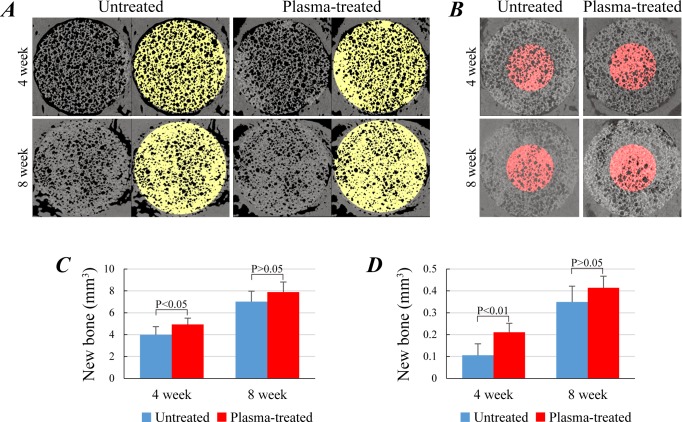
In vivo implantation of IP-CHA discs.(A) Images of μCT analysis of untreated and plasma-treated IP-CHA discs at 4 and 8-week time points after implantation. Yellow denotes the bony density (i.e. IP-CHA and newly-formed bone inside the pores). (B) Pink denotes the bony density in the discoid images (φ2.5 mm, 0.67 mm height) extracted from the innermost twelfth part of the implant. Quantitative analysis of newly formed bone in the whole (C) and the innermost part (D) of the IP-CHA disc. Data were represented as mean ± SD of 5 animals.